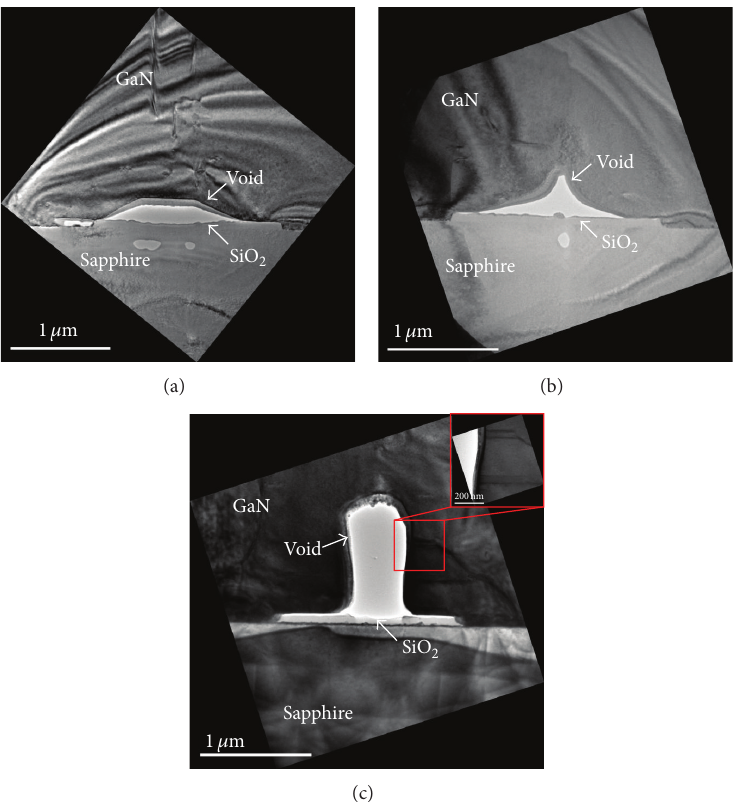
Figure 6: The TEM images of (a) sample-R, (b) sample-T, and (c) sample-P.